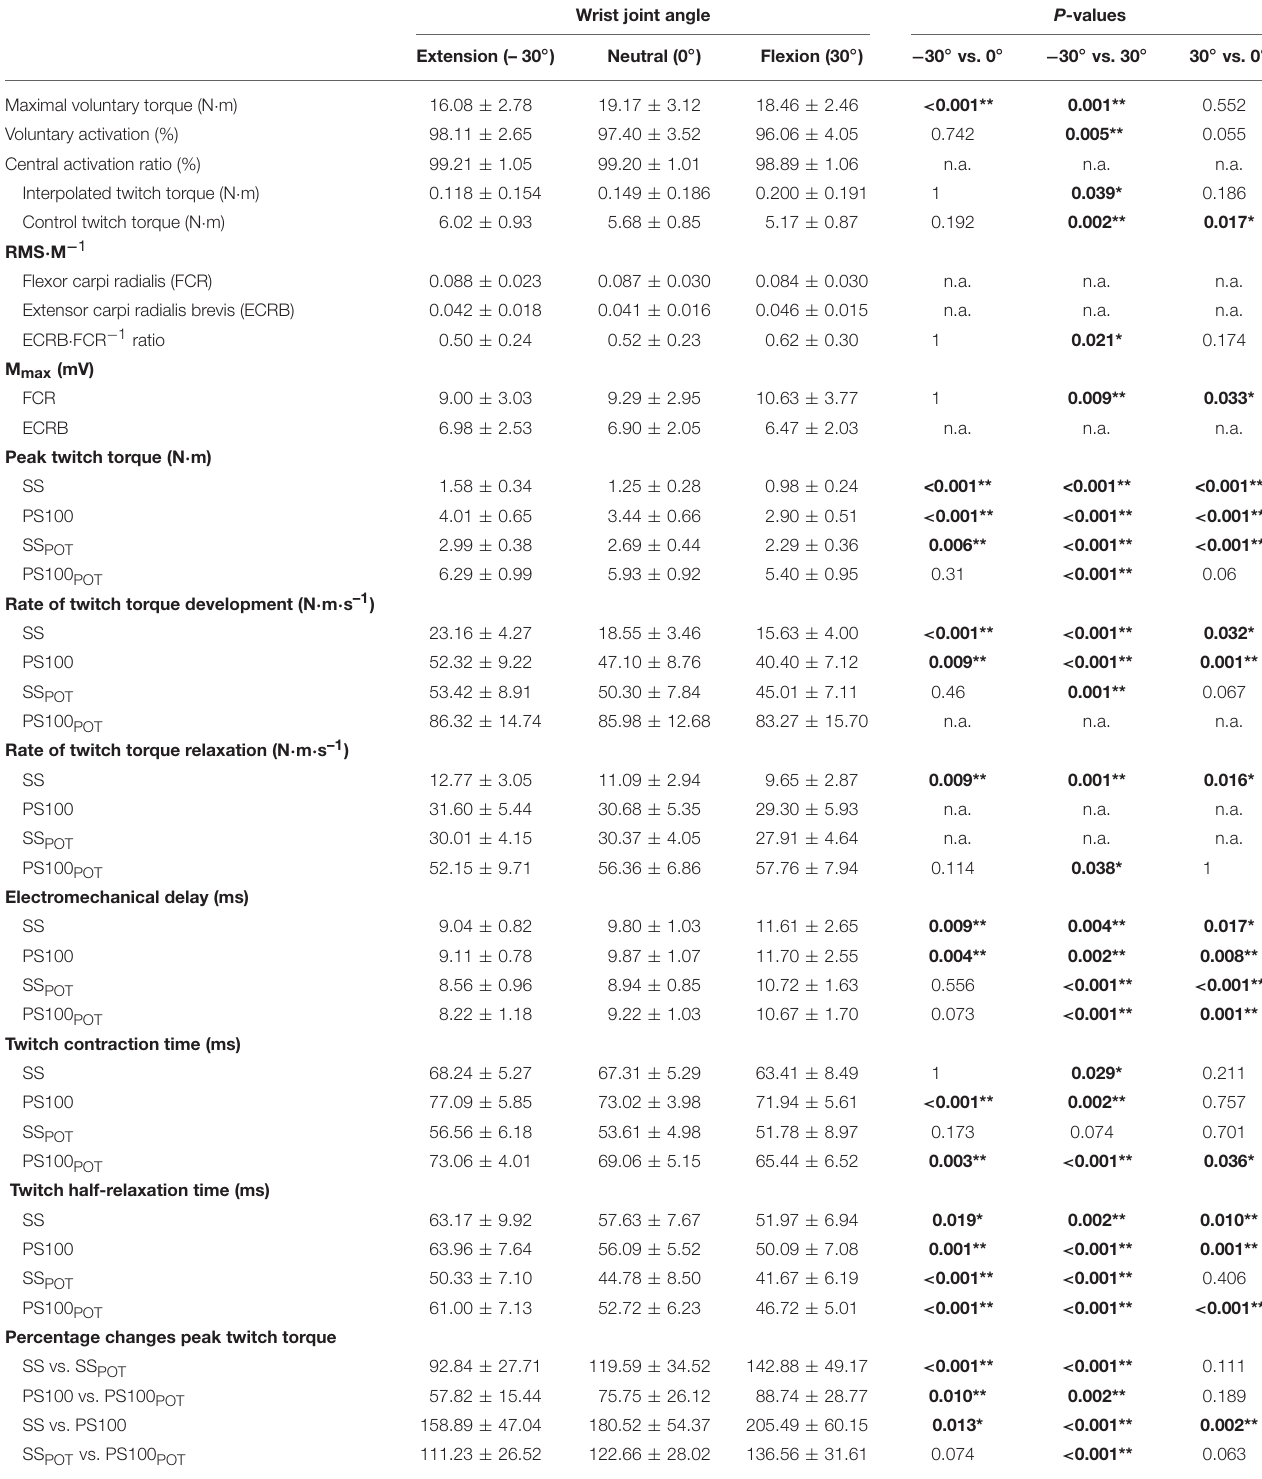
TABLE 1 | Neuromuscular function of the wrist flexors depending on the wrist joint